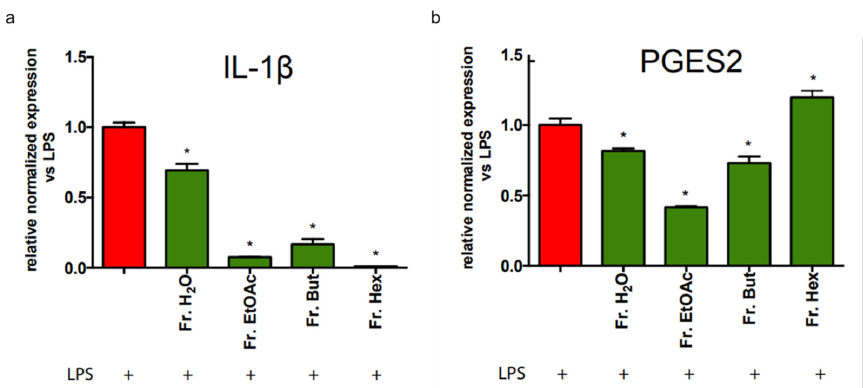
Figure 11. RT-PCR analysis of IL-1 β and PGES2 gene expression in BV-2 cells treated with different chestnut leaf extract fractions. BV-2 cells were treated for 3 h with 50 μ g/mL of different leaf-derived extract fractions, then stimulated with 0.5 μ g/mL LPS for a total of 24 h. At the end of incubation, RNA was extracted from cells and samples were subjected to RT-PCR analysis using a specific pri- mer for IL-1 β ( a ) and PGES2 ( b ), as reported in the Materials and Methods section. The relative mRNA contents were normalised to LPS-treated cells (red bars). Relative quantification is obtained